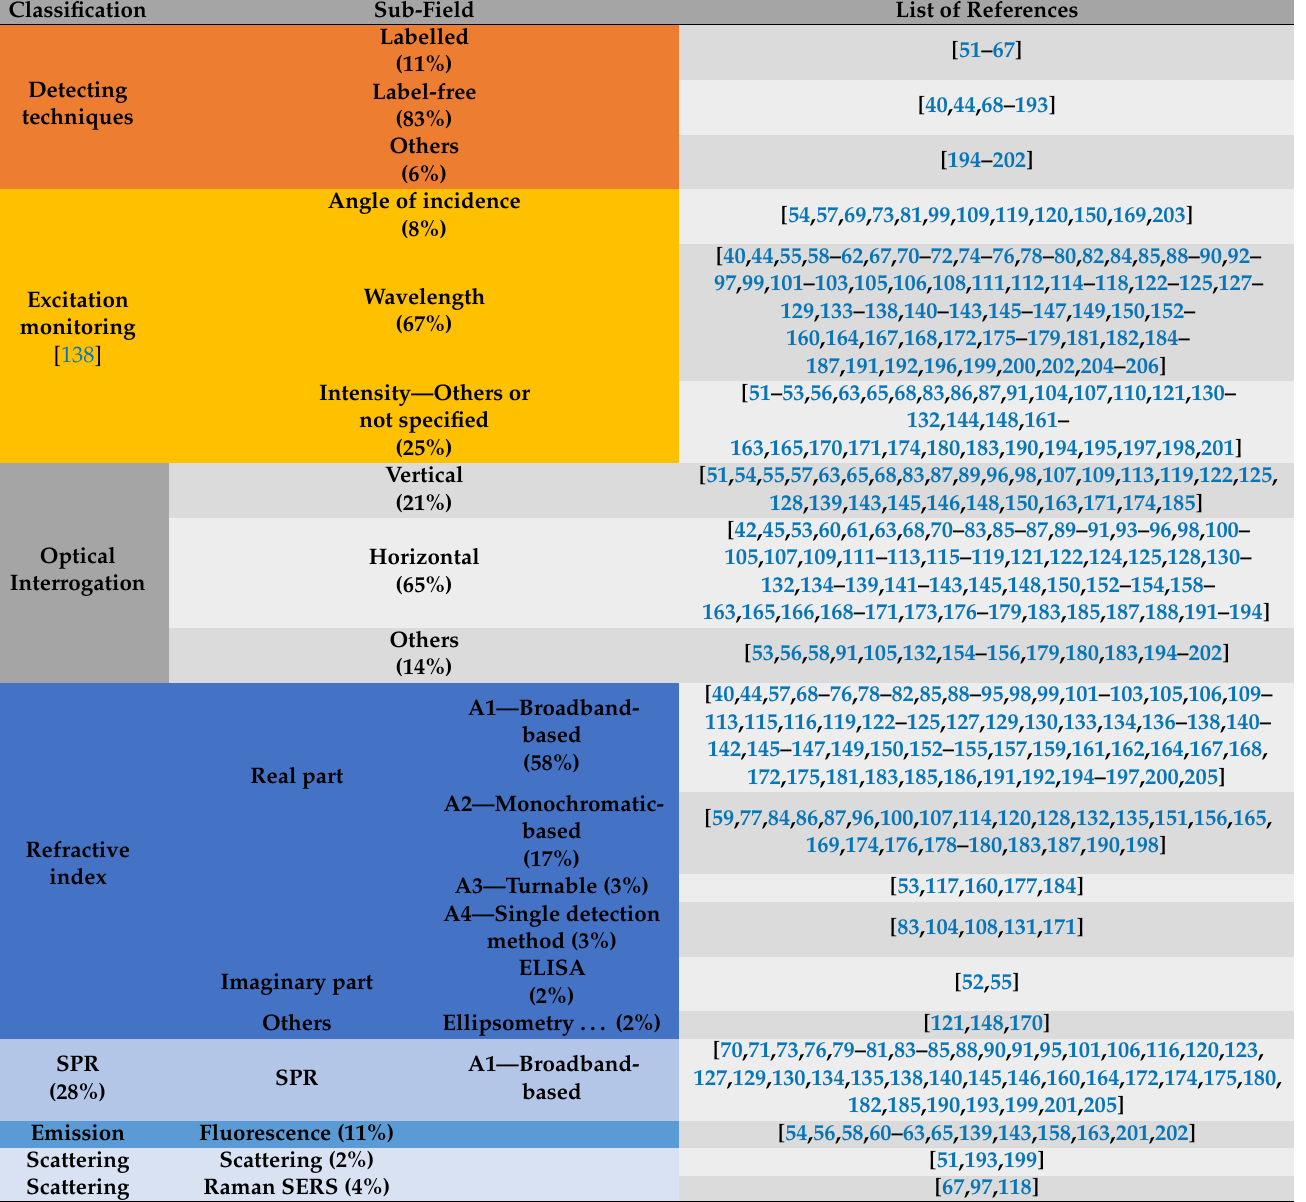
Table 1. Classification of the Scientific Publications included in the study according to their categories and their